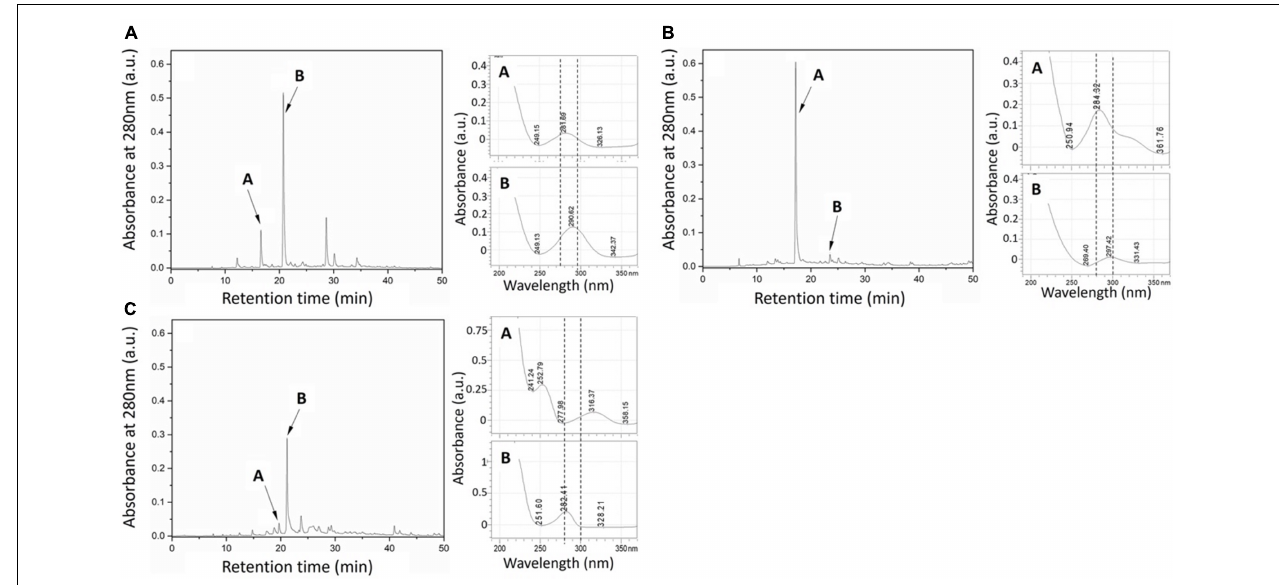
FIGURE 2 | HPLC chromatograms (left for each sample) of (A) Elata, (B) Pmin, and (C) Pch fungal metabolite extracts taken at 280 nm. Labels (A,B) indicate the putative phenolic peaks selected (abs. ∼ 280 nm). (Right) UV spectra of the two most abundant extract peaks.